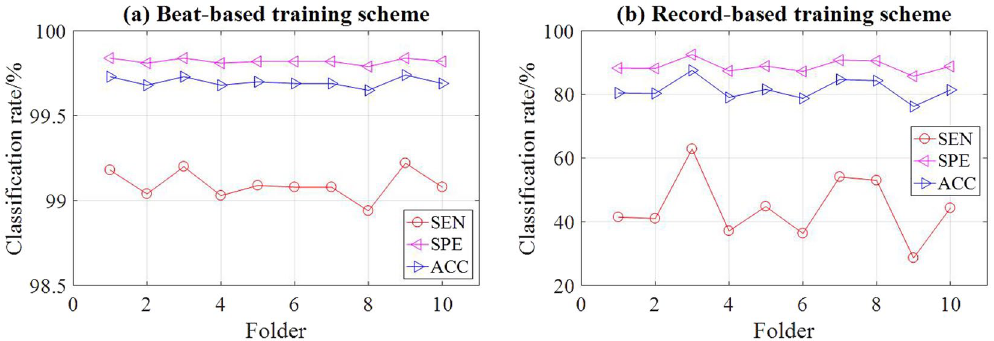
Figure 6. Classification performance for the beat-based ( a ) and record-based ( b ) schemes using 10-fold cross validation.